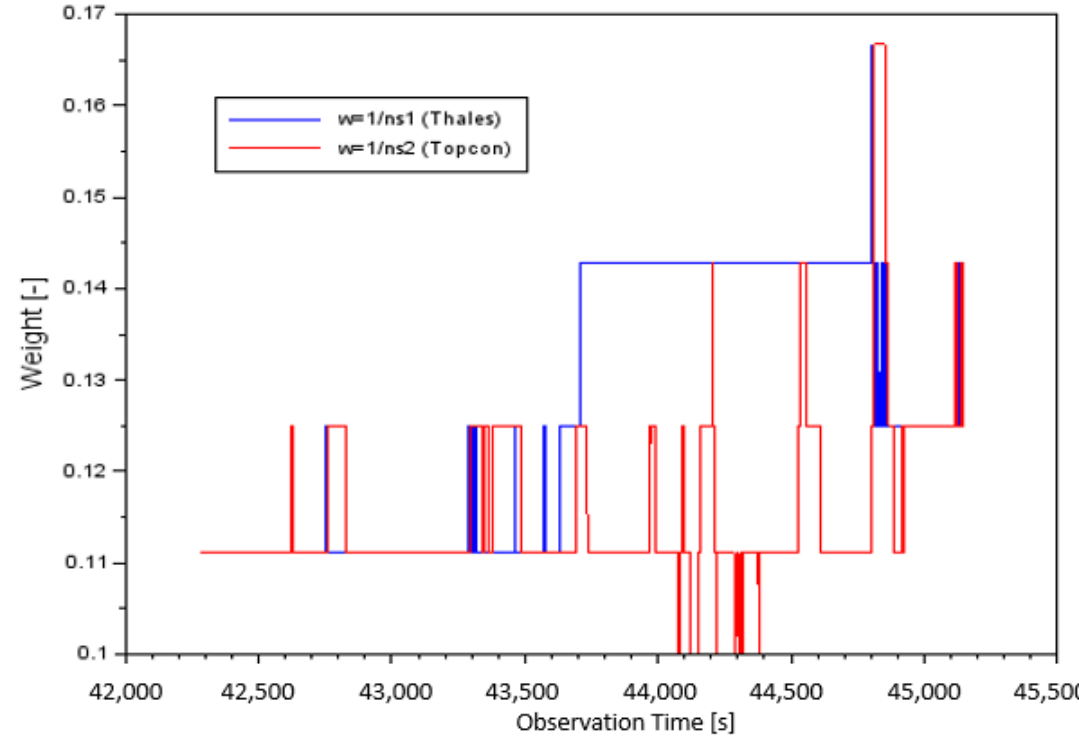
Figure 2. The weight value for Case I: Thales (blue) and Topcon (red).